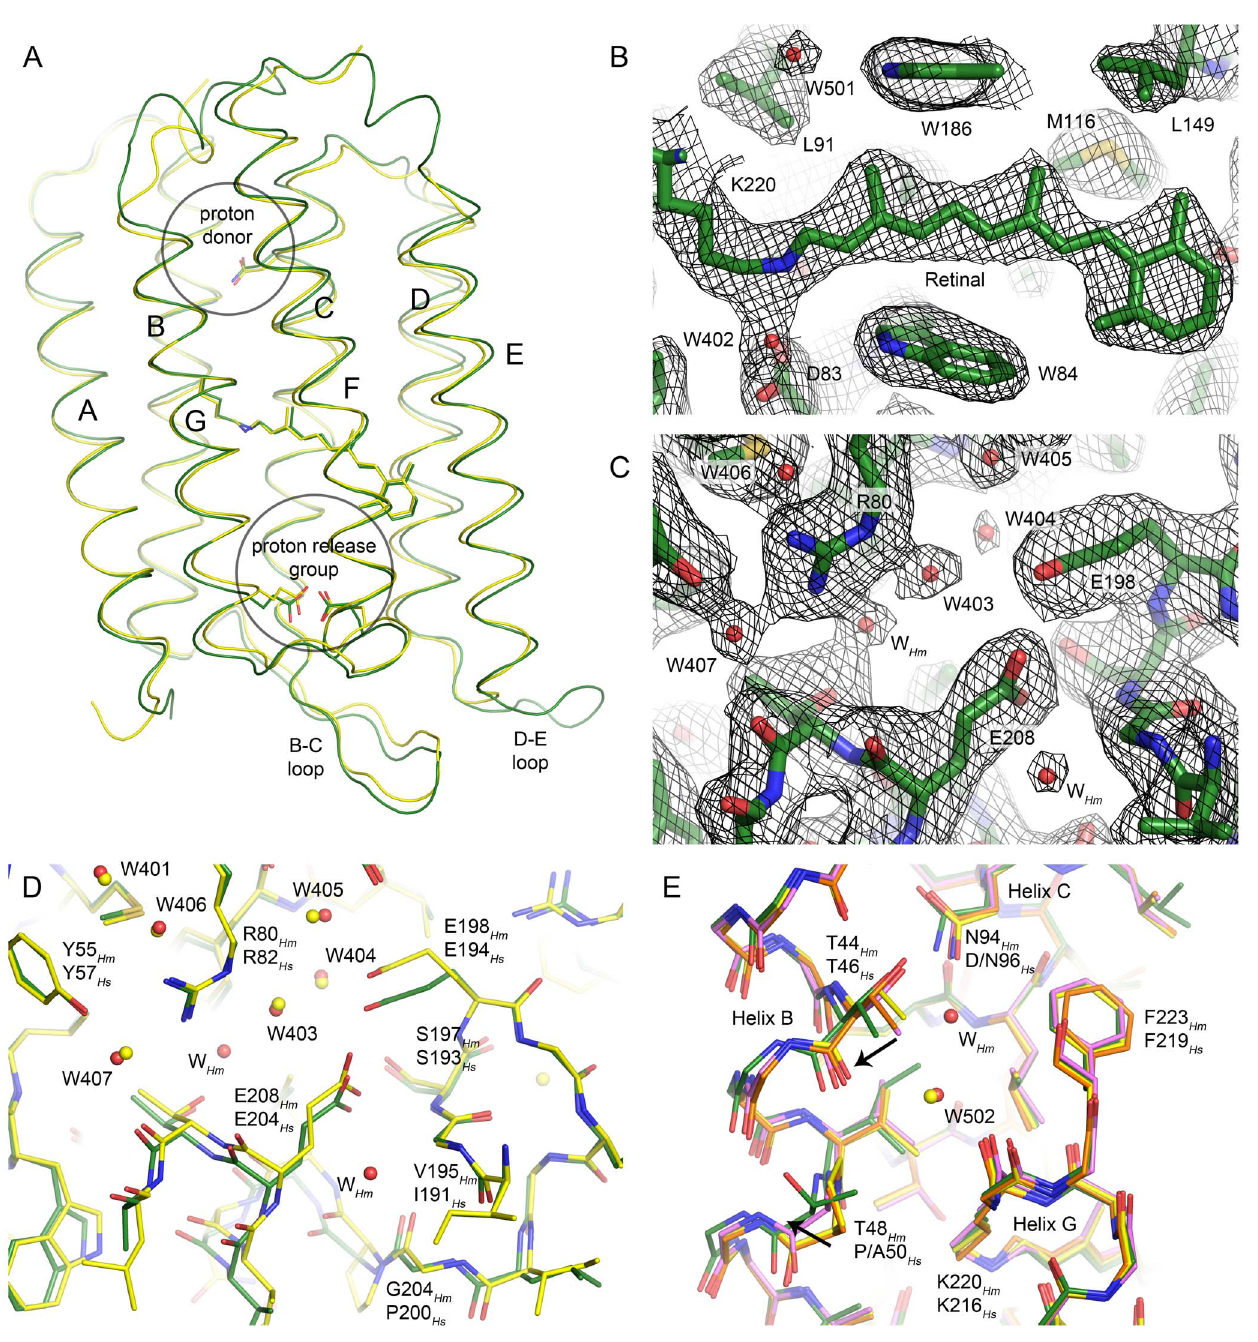
Figure 4. Crystallographic structure of the Hm BRI D94N mutant. (A) Comparison of the Hm BRI backbone structure (green) with that of Hs BR [23] (yellow). (B) 2F o -F c electron density maps in the vicinity of the retinal. The maps are contoured at the level of 1.5 s . (C) 2F o -F c electron density maps in the proton release region. The maps are contoured at the level of 1.2 s . (D) Comparison of the Hm BRI proton release group (green) with that of Hs BR [23] (yellow). Overall, the conformations of the side-chains and positions of water molecules are very similar. However, the water accessible space is larger in Hm BRI, and additional water molecules are observed (W Hm ). One of the reasons for this difference might be the substitution of Hs BR’ proline 200 with the glycine 204 in Hm BRI, that allows unlatching of the extracellular part of the helix G. (E) Comparison of the Hm BRI proton donor region with that of wild-type Hs BR [23] (green) and its D96N [30] (orange) and P50A [32] (magenta) mutants. It appears that in Hm BRI the effects of the D94N mutation and the P50 Hs R T48 Hm substitution combine and result in a larger displacement of the helix B relative to the helices C and G (black arrows), as similar displacements are present in the P50A and D96N mutants of HsBR, albeit with a smaller amplitude.